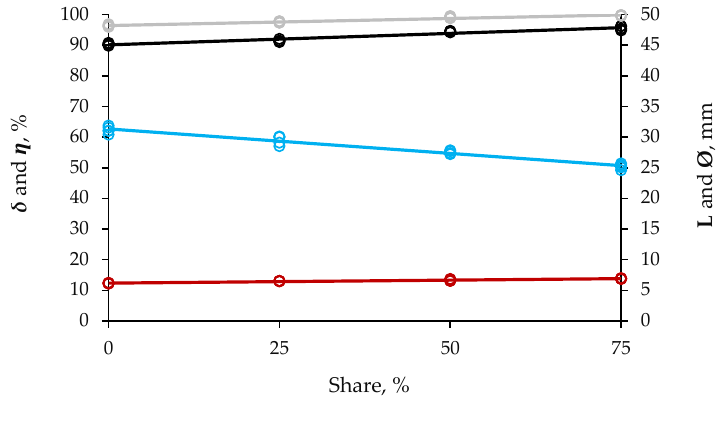
Figure 2. Effect of share of residual biomass from distillation of cellulosic bioethanol in the blend with sugarcane bagasse on the physicochemical quality of hybrid non-wood pellets. The steeper the line, the larger the probability of the factor to becoming the cause of significant variability, as it gains in linearity; length ( L ), diameter ( Ø ), durability ( δ ), and resistance to abrasion ( η ). Durability and resistance to abrasion in composite pellets were in the ranges of 97.10 – 99.95 and Physicothermal 90.70 – 92.55%, respectively, regardless of the size of addition. These variables of mechanical stability